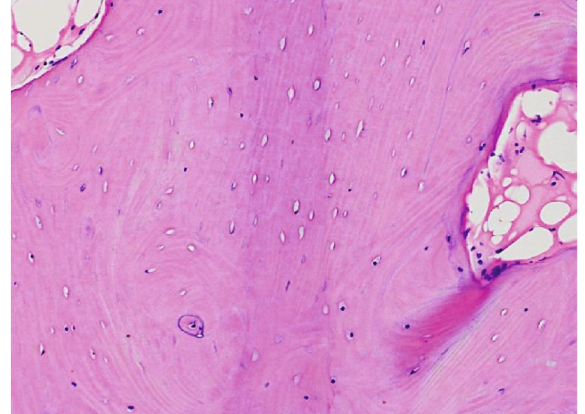
Figure 5: Histology of the fracture site. In the high magni fi cation of the region (200x), thickening of the bony trabeculae with few cells on the surface is observed in the fracture site.